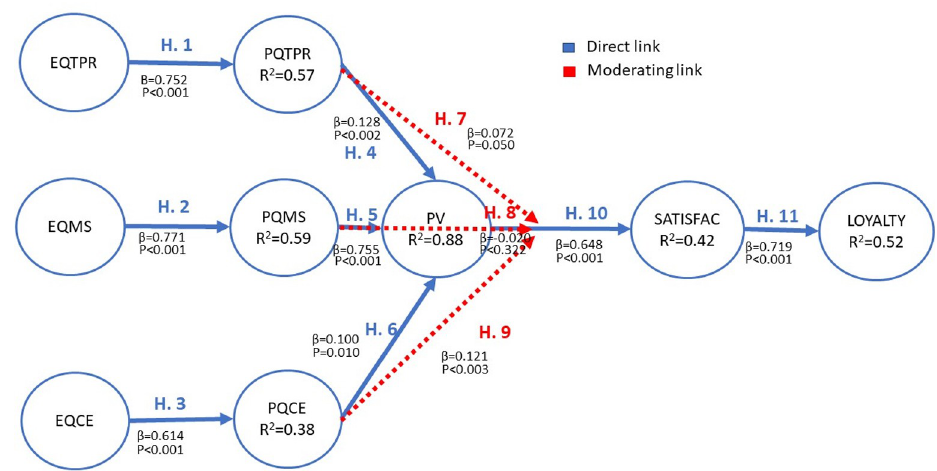
Fig 2. Loading factor and limiting probability of the proposed causal relationships.